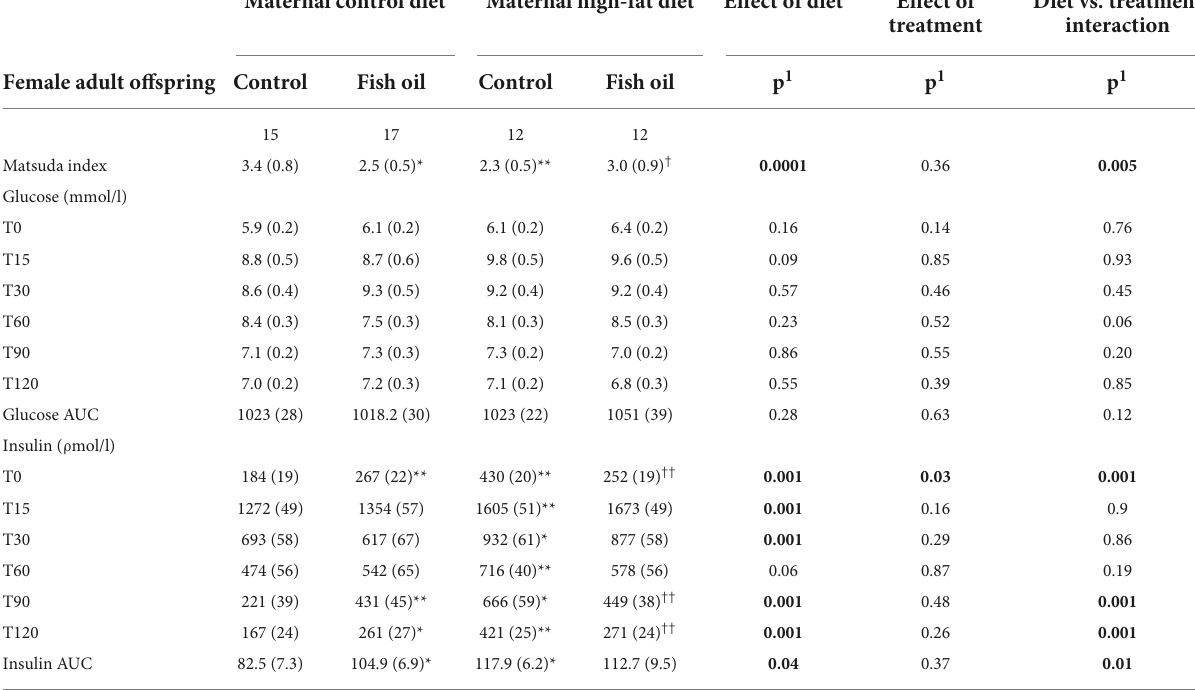
Diet vs. treatment treatment interaction